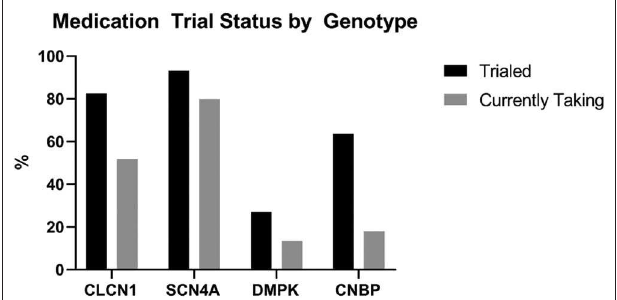
FIGURE 4 | Proportion (of those currently taking a medication) of individuals taking each type of antimyotonia agent.